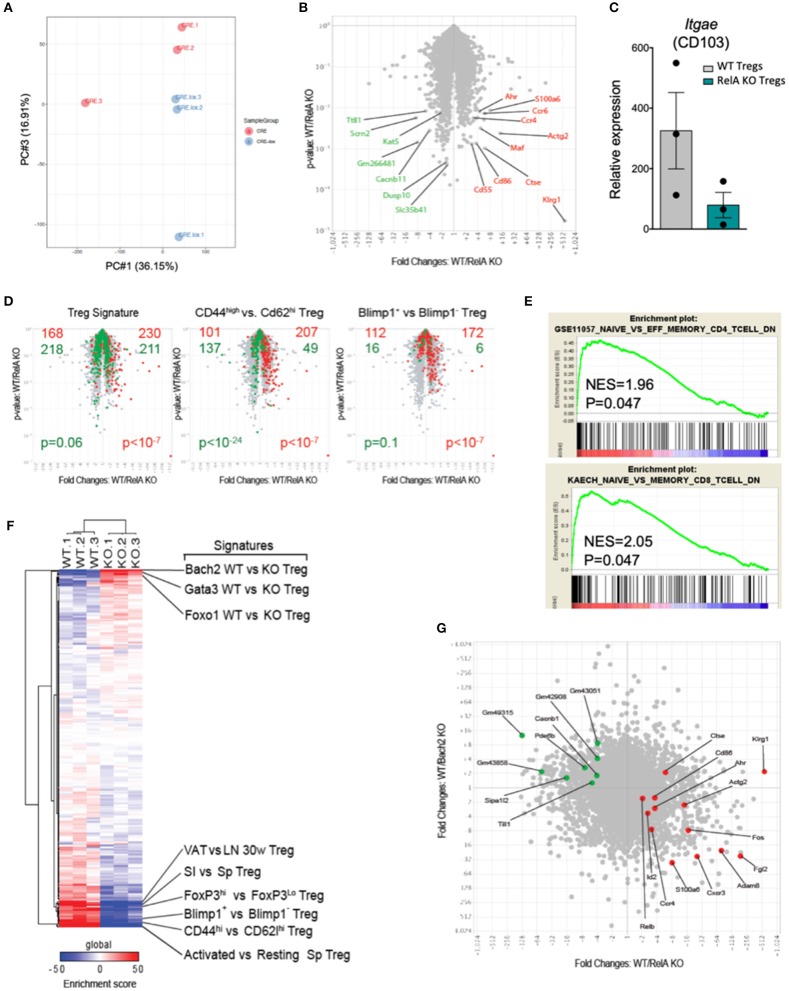
RelA-deficient Tregs have identity and activation defects. (A) PCA analysis of WT and RelA KO Tregs. (B) Volcano plot of WT vs. RelA KO Tregs. Red and green indicate transcripts up- and down-regulated, respectively, by WT Tregs cells. (C) Relative expression of Itgae (CD103) expressed in counts per million in WT and RelA KO Tregs. (D) WT vs. RelA KO Tregs (as in A) overlaid with various Tregs signatures. Red and green indicate genes up- and down-regulated, respectively, in each signature (chi-squared test for p-value). (E) GSEA plots of RelA-deficient Tregs compared with indicated set of genes up-regulated in effector memory CD4 (upper panel) and memory CD8 conventional T cells (lower panel) (32). (F) Heatmap for the enrichment score of each gene signature (VAT, visceral adipose tissue; LN, lymph nodes; SI, small intestine; Sp, spleen). (G) Fold change-fold change plot of WT vs. RelA KO Tregs (x-axis) and WT iTregs vs. WT Bach2 KO iTregs [y-axis, from published data (7)]. Red and green transcripts from (A). For mouse and experiment numbers, see Supplementary Table 1.